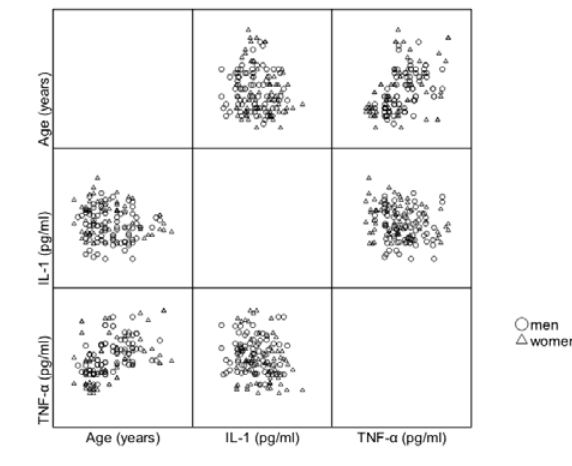
Figure 1: Matrix scatter show the correlation between age, IL-1 and TNF-α,